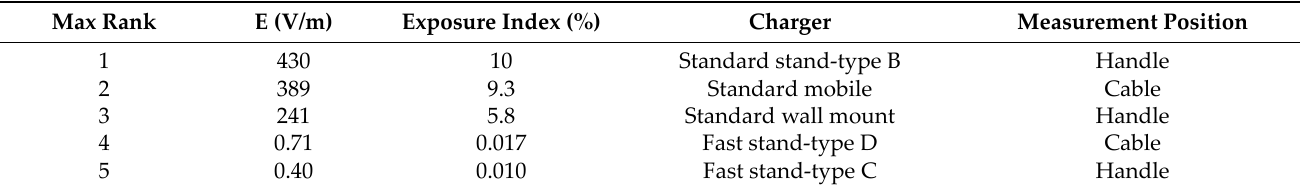
Table 5. Summary of the maximum ranking of the electric field measurement results.